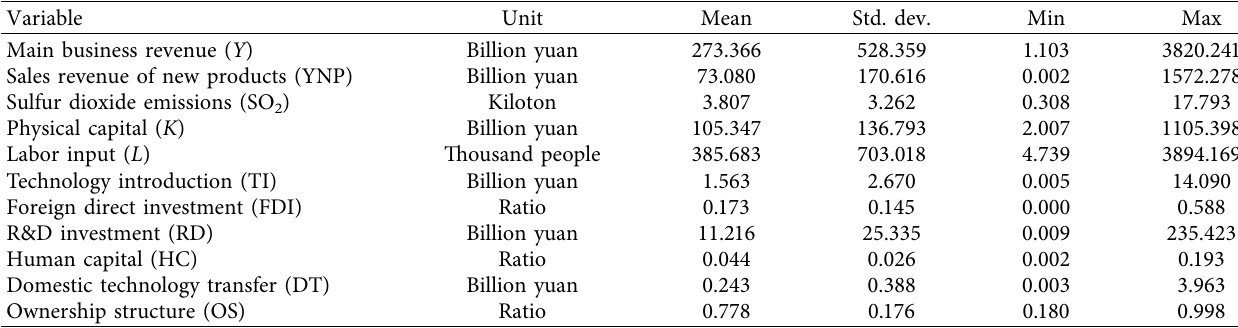
Table 1: Descriptive statistical results of the variables.